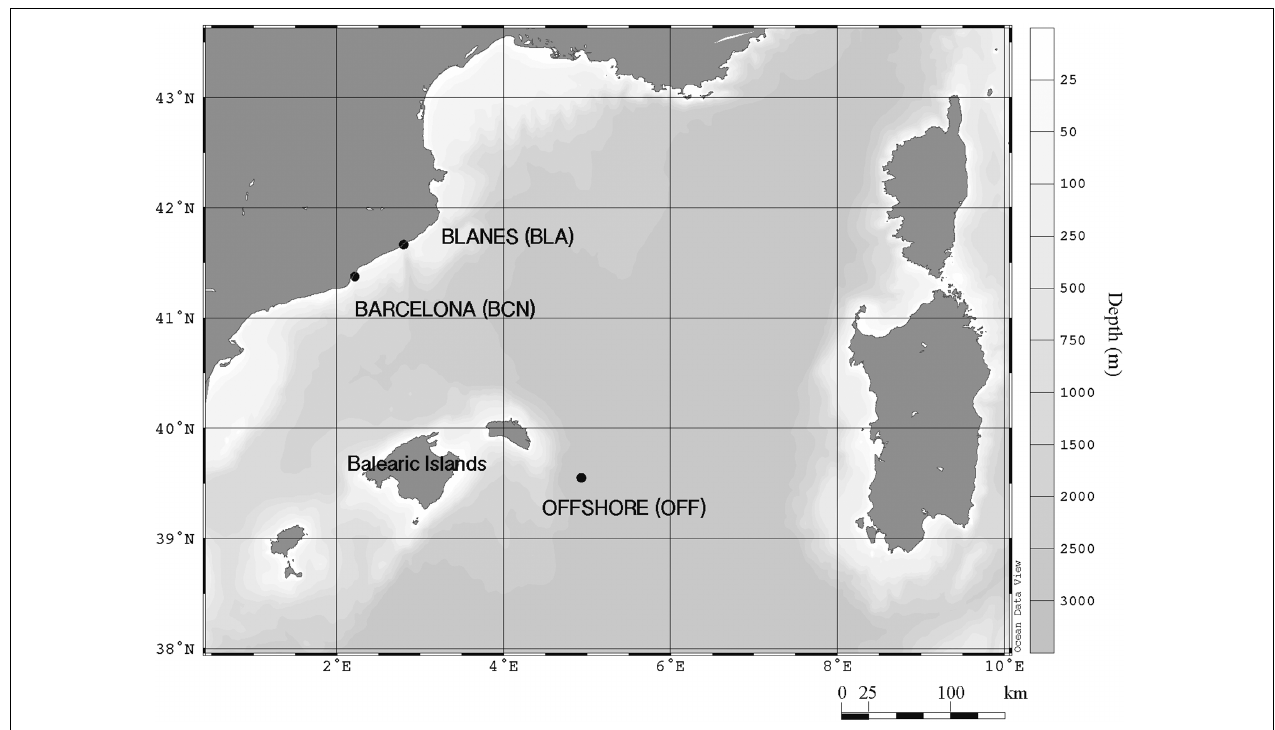
FIGURE 1 | Geographical location of the two coastal sampling stations (BCN and BLA) and the OFF station, in the northwestern Mediterranean Sea.